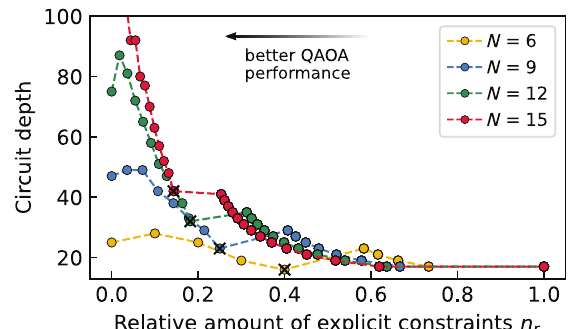
FIG. 6. The circuit depth required to implement one step in the QAOA protocol for complete graphs of various problem sizes N . The x axis represents different divisions of the con- straints into explicit and implicit implementations: for small values of n r , only three-body constraints are enforced